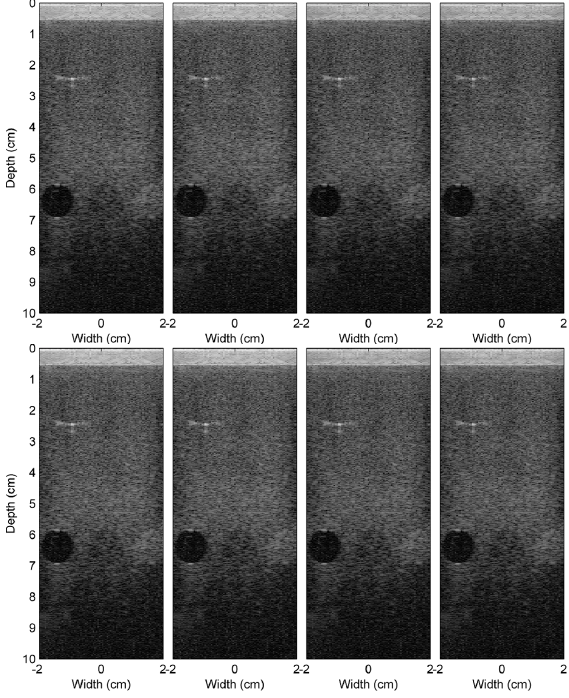
Figure 7. Comparison of the ultrasound images (from Experiment 1) reconstructed using eight different schemes, C-N-D, C-IQ-D, P-N-D, P-IQ-D, C-N-single (S) , C-IQ-S, P-N-S and P-IQ-S, from the left to the right and from the top to bottom, respectively.